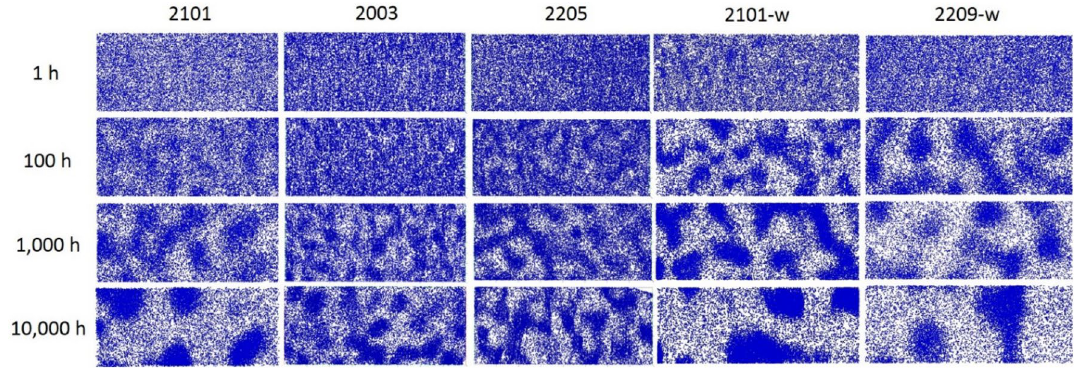
Fig. 2 Cr distribution (blue dots) with aging (1 h, 100 h, 1000 h, and 10,000 h) at 427 °C of all five alloys. Note that the viewing size is 40 × 15 × 5 nm 3 , with 5 nm representing the sampling depth